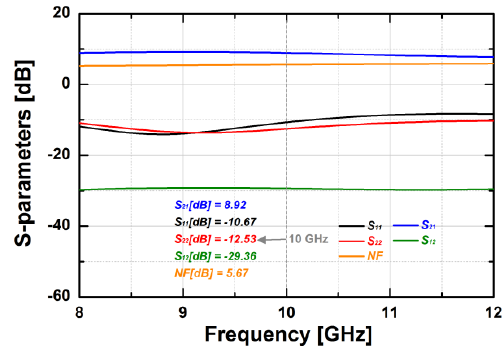
Figure 14. The simulated S-parameters of the BDGA.